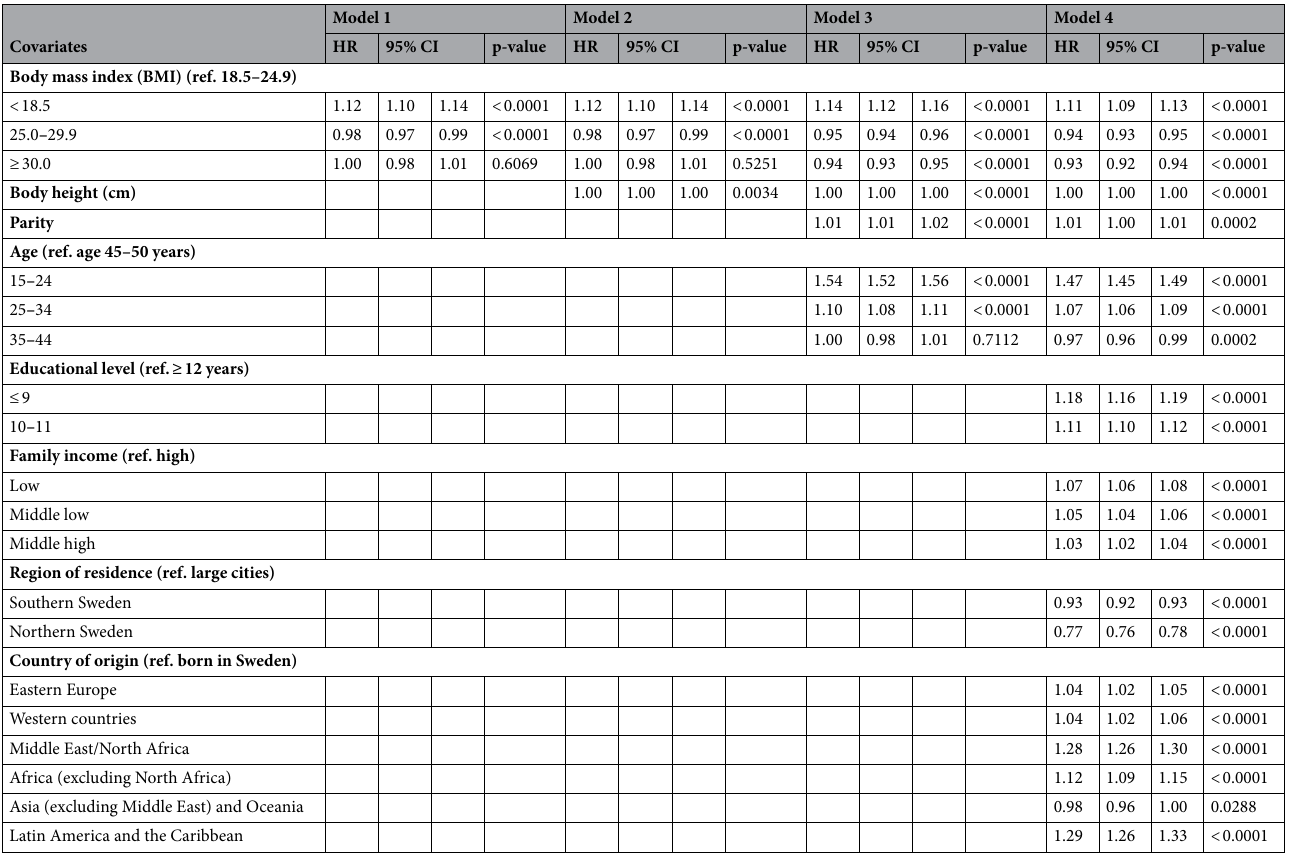
Table 1. Inverse association between BMI and cystitis in fertile women (adjusted for height, parity, and sociodemographic factors). Model 1: Univariate model; Model 2: Adjusted for body height; Model 3: Adjusted for body height, age, and parity; Model 4. Fully